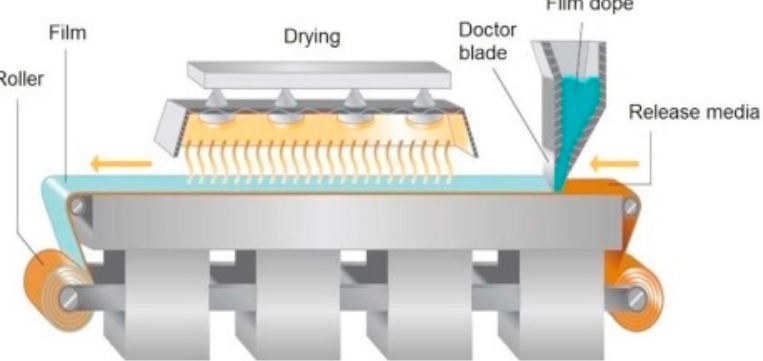
Figure 4. Manufacturing process of buccal films by solvent casting method (Reprinted with permission from Karki et al. 2016 [57]).